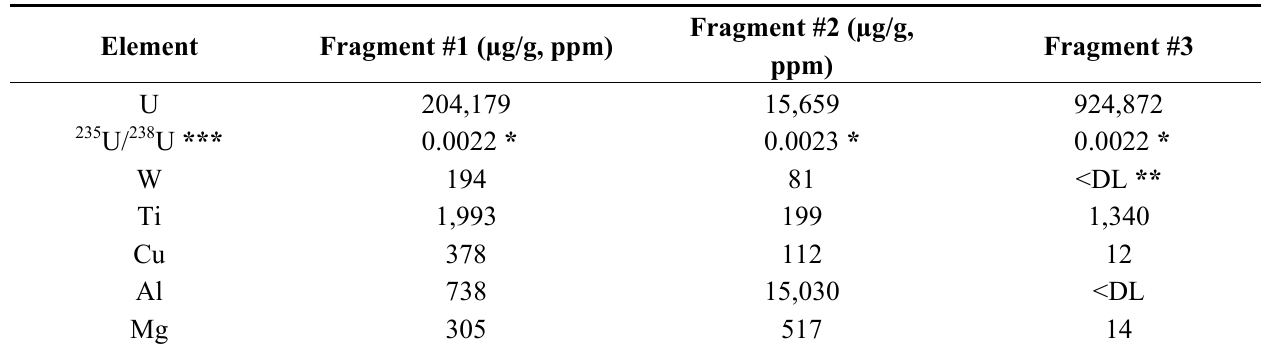
Table 2. Elemental composition of uranium- and depleted uranium-containing fragments (case number 2) Element